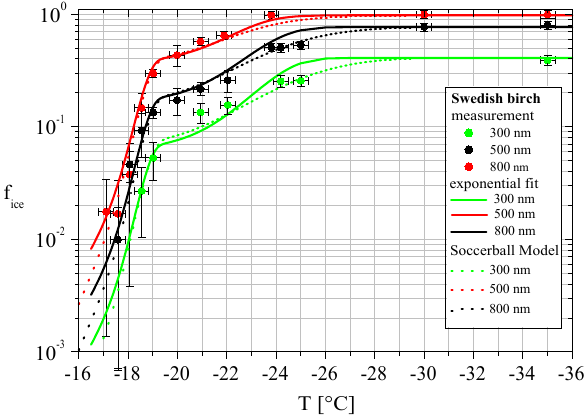
Fig. 11. Left panel: parameterizations of J het ,α (red lines, parame- ters in caption of Fig. 4) and J het ,β (blue lines, parameters in caption of Fig. 10). Additionally the J het values from the measurements are plotted as colored dots and circles. Right panel: λ α , λ β and λ tot of the Swedish birch pollen washing water